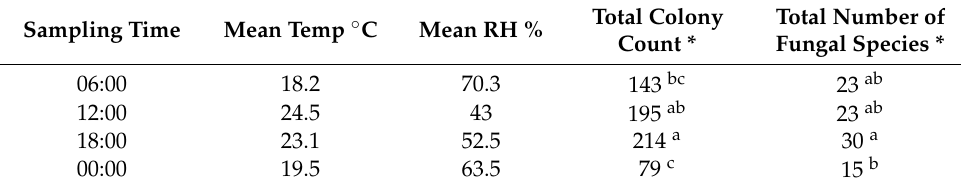
Total Colony Total Number of Count * Fungal Species *